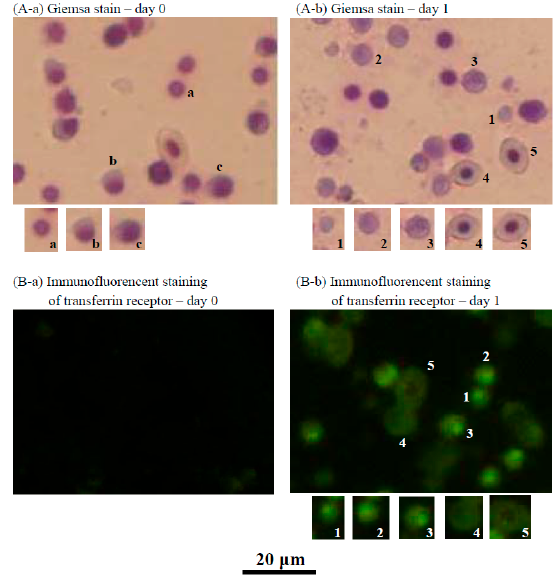
Figure 3. Cells collected from the suspension cultures of crucian carp head kidney cells grown in medium supplemented with ZnCl 2 . ( A - a ) Giemsa-stained cells collected at day zero. The major cells were lymphocytes ( a ) (approximately 70%); other cells, including neutrophilic progranulocytes ( b ) and basophilic granulocytes ( c ) were also observed; ( A - b ) Giemsa-stained cells collected at day one. Various newly proliferated cells (approximately 42%) were identified as erythrocytes of different development stages: 1. lymphoid hemoblasts, 2. early erythroblasts, 3. polychromatophilic erythroblasts, 4. orthochromatic erythroblasts, and 5. erythrocytes; ( B - a ) Immunofluorescent staining of the transferrin receptor of the cells at day zero; no cells were stained; and ( B - b ) Immunofluorescent staining of the transferrin receptor of the cells at day one. Comparing the cell size and cell morphology in ( A - b ) and ( B - b ), the transferrin receptor immunofluorescent-stained cells were RBC stages 1, 2, and 3. RBC stages 4 and 5 and cells other than RBCs were not immunofluorescently stained.